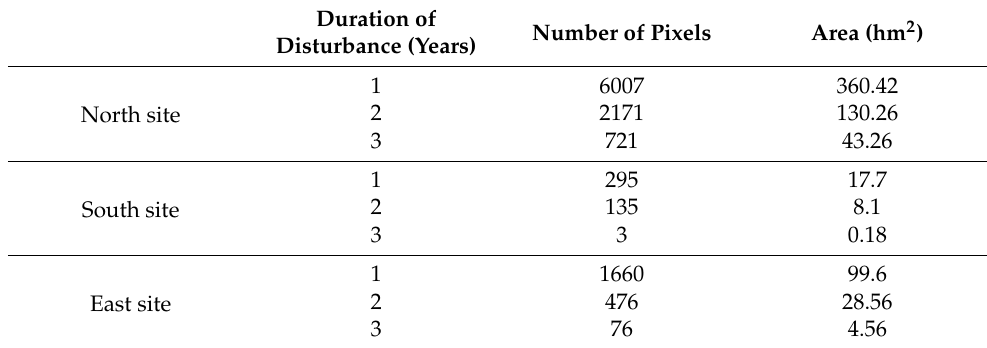
Table 3. Duration of the disturbance.